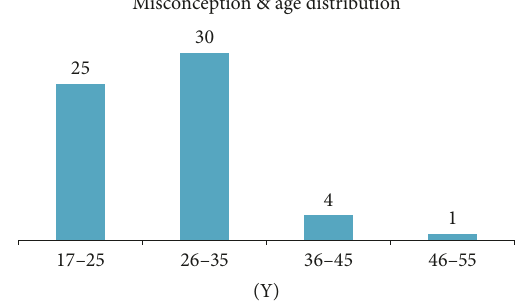
Figure 1: Distribution of misconception with age among respon- dents ( 𝑛 = 60 ).